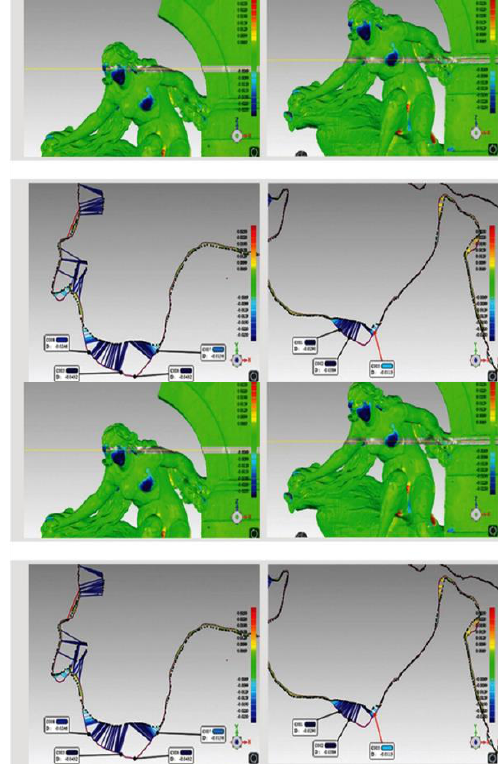
Figure1. The green zones represent a small deviation between the reference object and the test object. However, the parts of cyan or blue show a very important deviation between the two